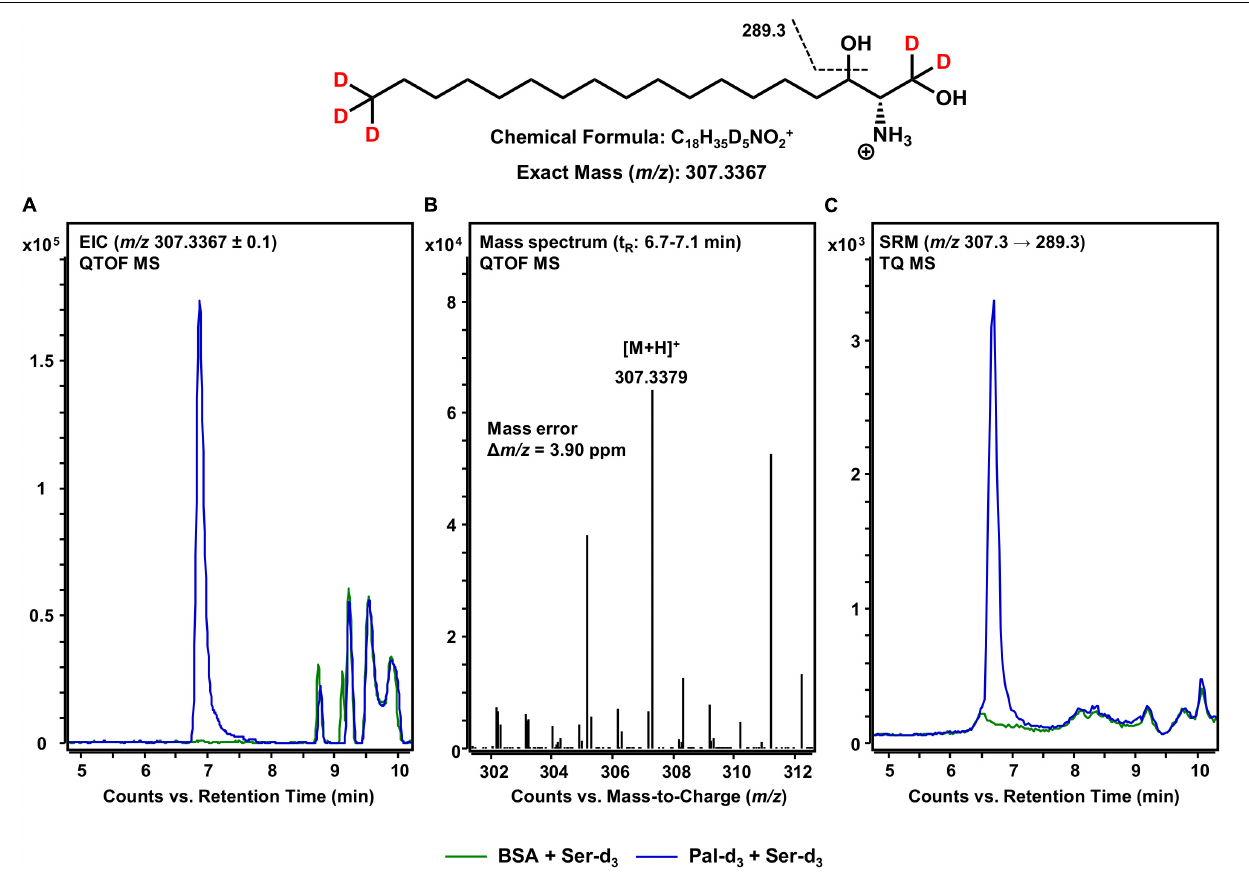
FIGURE 4 | De novo formation of d18:0 Sph-d 5 from 3KS-d 5 in the in vitro assay. (Top) Chemical structure, formula, and exact mass of the protonated molecular ion [M+H] + of d18:0 Sph-d 5 generated during electrospray ionization. Dashed black line represents the mass transition used for selected reaction monitoring (SRM). (A) Overlay of extracted ion chromatograms (EIC) of the microsomal de novo synthesis assay using palmitate-d 3 and serine-d 3 as substrates (blue) compared to the negative control omitting palmitate-d 3 (green). (B) Mass spectrum extracted from the EIC in the retention time window of eluting d18:0 Sph-d 5 with annotation of the molecular ion peak and the calculated mass error. (A,B) Analysis was conducted on a quadrupole time-of-flight mass spectrometer (QTOF MS). (C) Overlay of SRM analyses of assay (blue) compared to negative control sample (green) performed with a triple quadrupole mass spectrometer (TQ MS). t R , retention time. (A) In the t R range of 8.5–10 min, relatively abundant unidentified matrix components ( m/z : 307.2367 ≤ × ≤ 307.4367) eluted from both the assay and negative control samples. (C) Concordant matrix signals were diminished, with increased specificity achieved by analyzing compound-specific fragmentation.